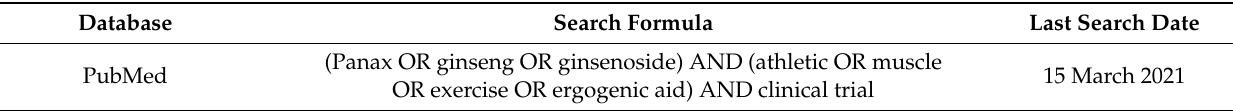
Table 1. Search formula for searching literature and search date. Database Search